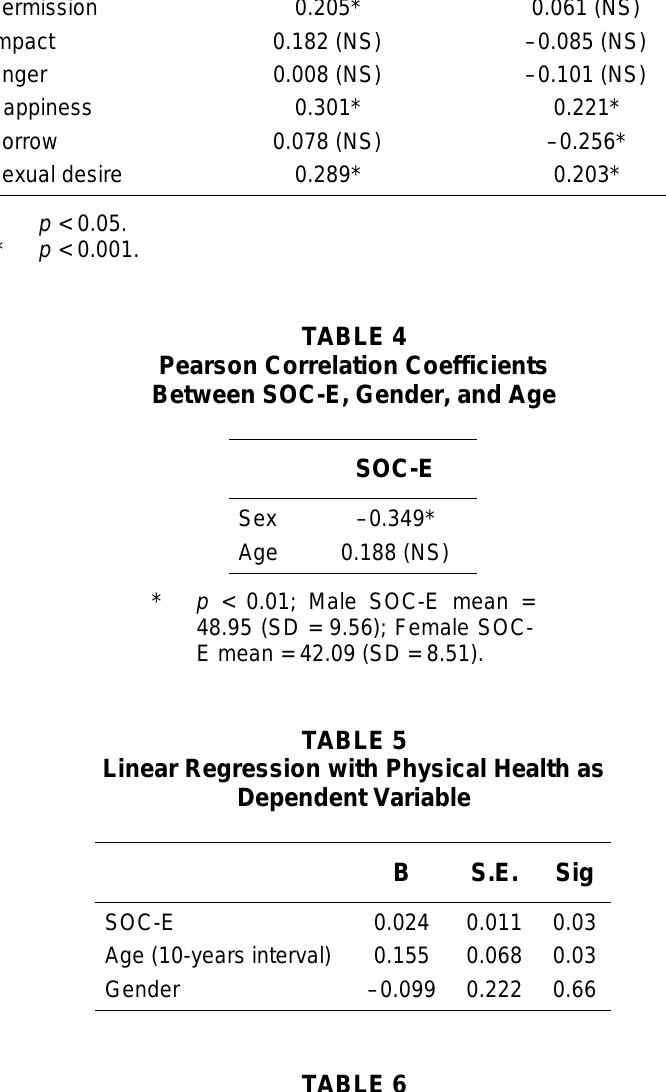
Linear Regression with Psychological Health